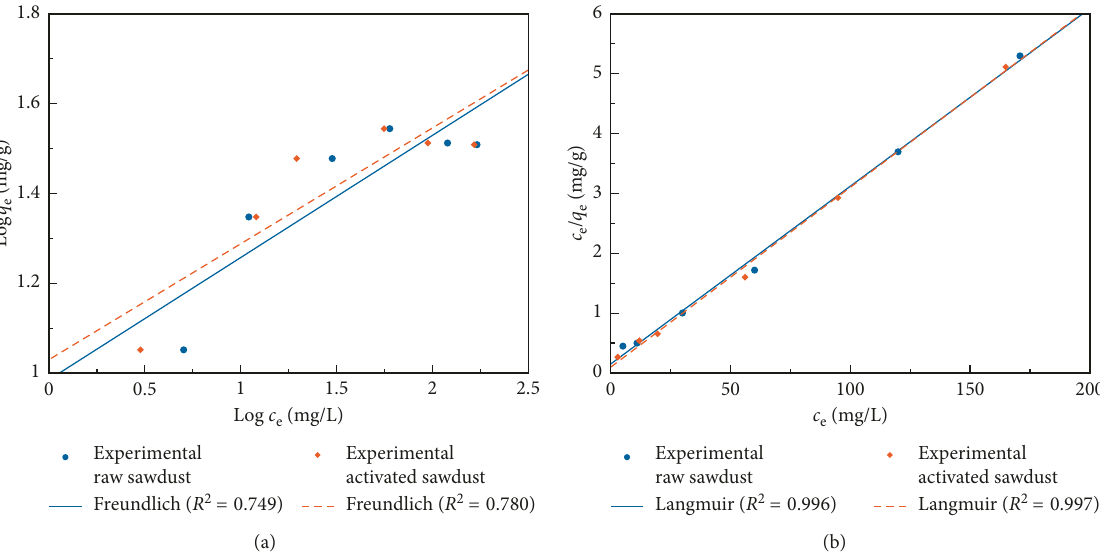
Figure 7: Freundlich (a) and Langmuir (b) linear isotherms of raw and chemically treated sawdust for chrysoidine removal.